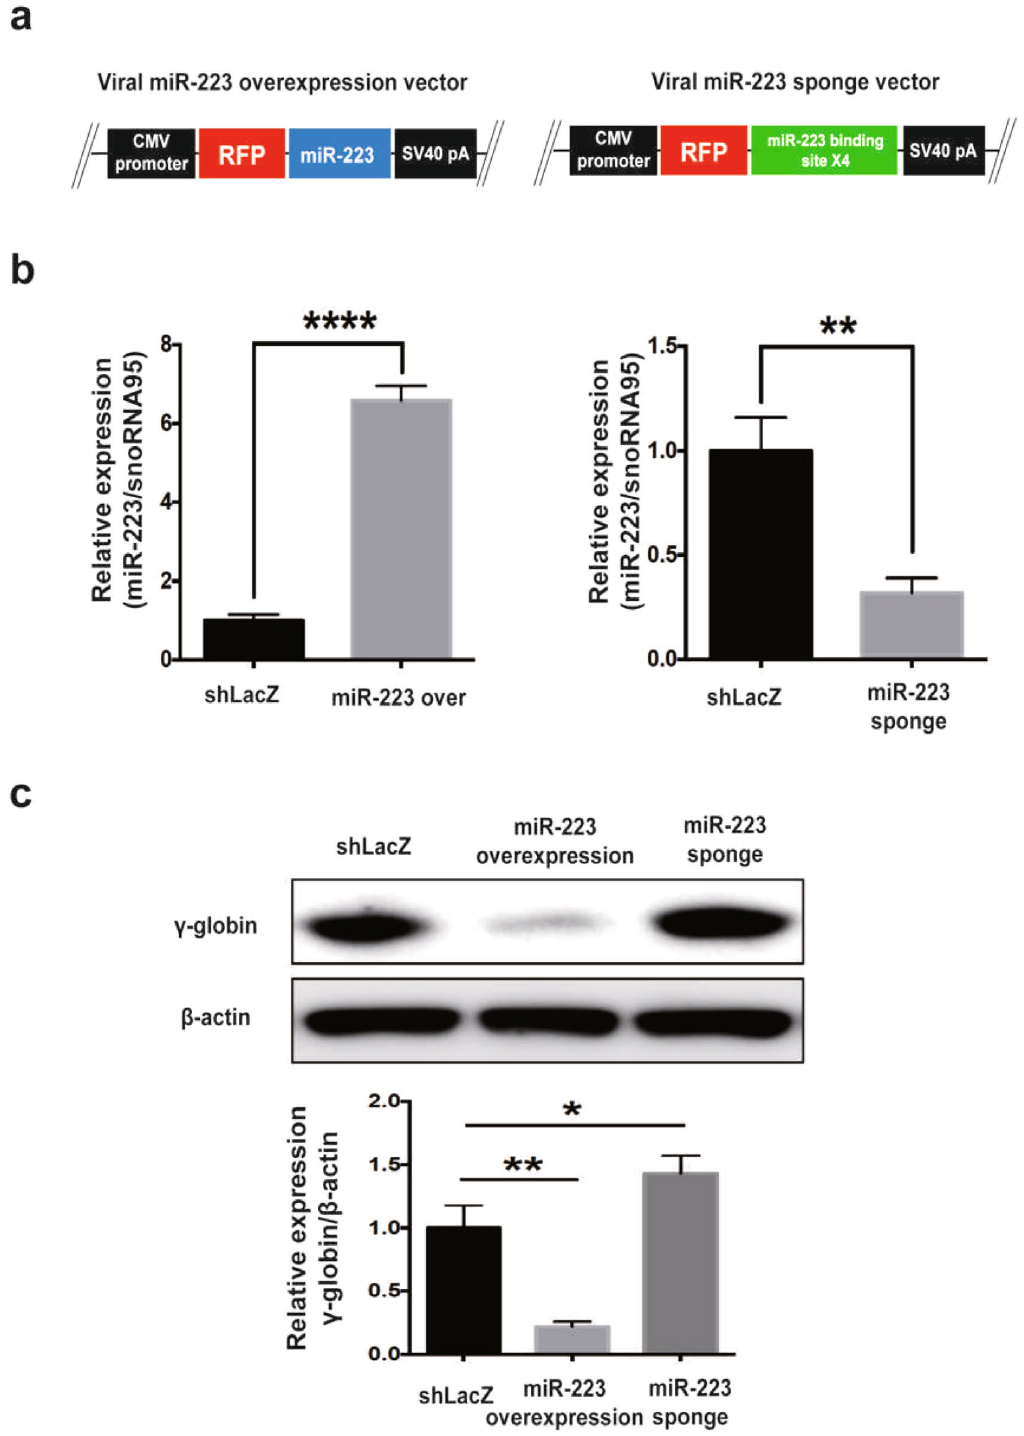
Figure 6. miR-223-3p targeting up regulates γ -globin expression. ( a ) Overview of the barcoded lentiviral miRNA over expression and sponge vector. miRNA expression is driven by the viral CMV promoter. This vector contains the miRNA and ~500 bp endogenous flanking sequences in the 3 ′ UTR of the RFP (Red Fluorescent Protein). To allow selection of target cells, we incorporated a dual selection cassette of puromycin gene. ( b ) RT- qPCR validation for miR-223-3p over expression and sponge repression in K562 cells. ( c ) Western blot analysis of γ -globin expression by viral miR-223-3p over expression or sponge repression in K562 cells. Experiments were performed in triplicates. The values represented are mean ± SD, t-test analysis, * P < 0.05, ** P < 0.01, **** P < 0.0001, t-test, Prism6 (GraphPad Software